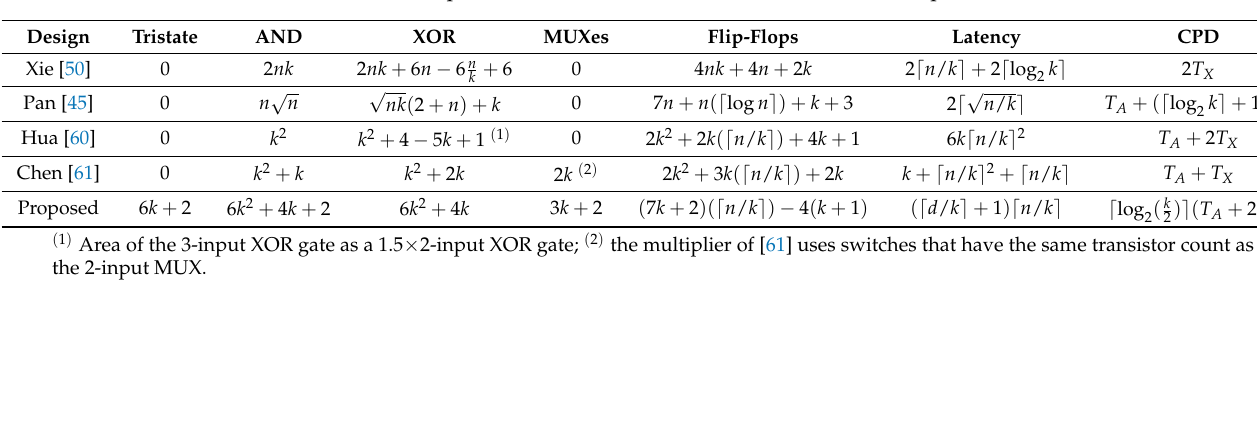
Table 1. Comparison between different word-serial field